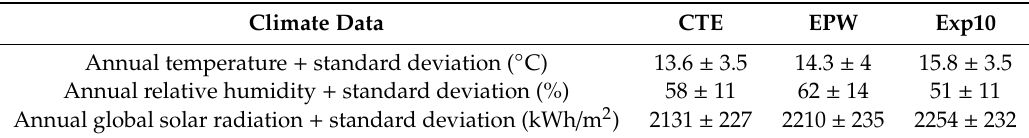
Table 4. Annual and mean standard deviation obtained for the main meteorological variables of the studied files. Climate Data CTE EPW Exp10 Annual temperature + standard deviation ( ◦ C) Annual global solar radiation + standard deviation (kWh / m 2 ) 2210 ± 235 2254 ± 232